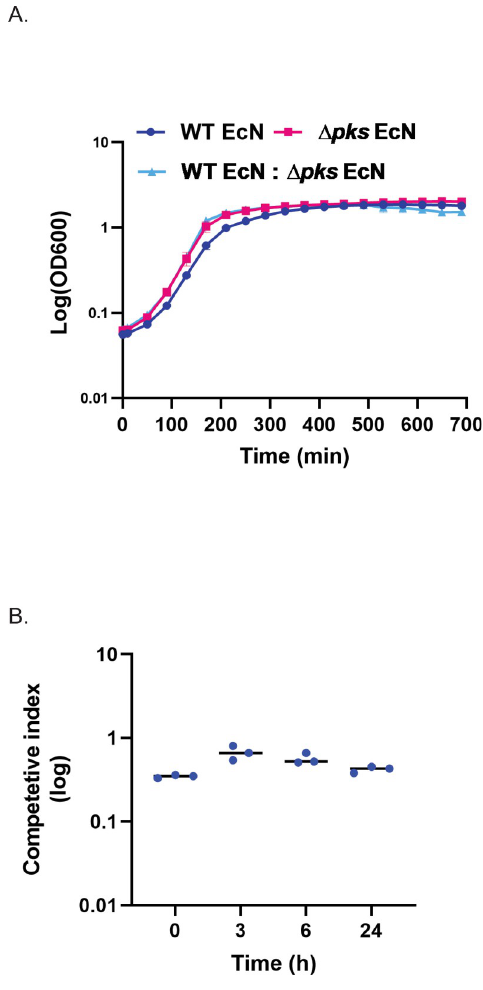
Fig 3. In vitro evaluation of EcN and Δ pks EcN fitness. A) Growth curves of WT EcN (dark blue), Δ pks EcN (pink) and both strains in mixed culture/competition (inoculated at a 1:1 ratio, light blue). Data are the mean and SD of triplicate cultures grown in LB media. B) Competitive index for Δ pks EcN and WT EcN over a 24h period of growth in LB media. Competitive indexes were calculated at each time point by dividing the number of recovered Δ pks EcN CFU (kanamycin resistant) by the number of recovered WT EcN CFU (streptomycin resistant). Each dot represents the CI determined from a single culture. A bar indicates the mean of the data. A competitive index of 1.0 indicates no difference in CFU recovery between the two